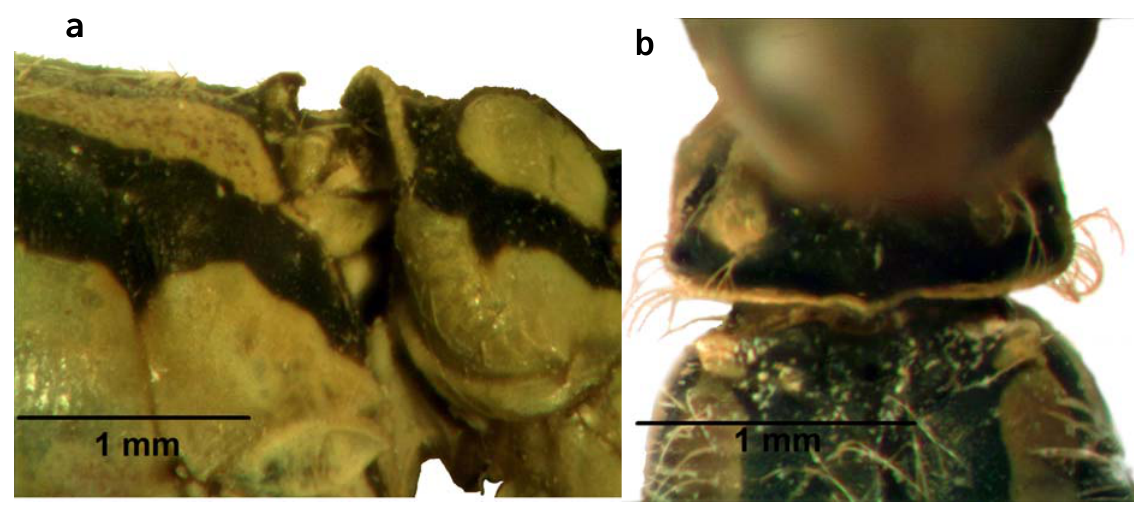
F IGURE 1. Ischnura intermedia, Head of male.